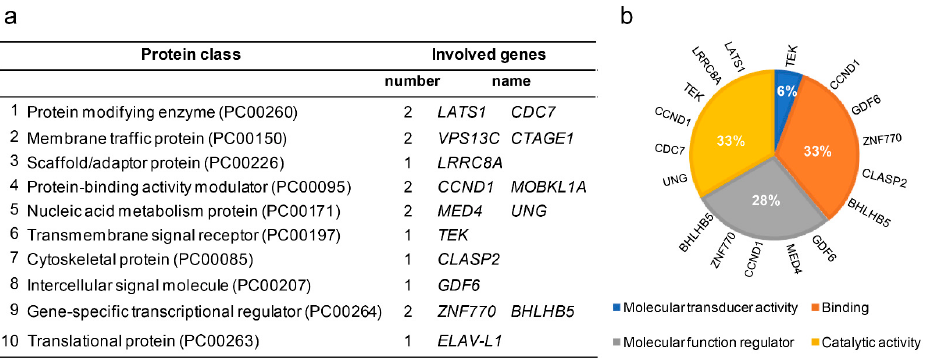
Figure 2. Representation of the GO analysis using the 21 genes list of Cluster 2 as input (Table S1 [194,197-218]): ( a ) categorization by protein class; ( b ) grouping by molecular functions. Six genes, namely PARP12, DICER1, LUZP4, UPF3B, ZFAND3, and OSGIN2 , are not included. Additional RBPs contained in the cluster are LUZP4 and UPF3B. LUPZP4 is involved in mRNA export from the nucleus. UPF3B is involved in the regulation of nonsense me-